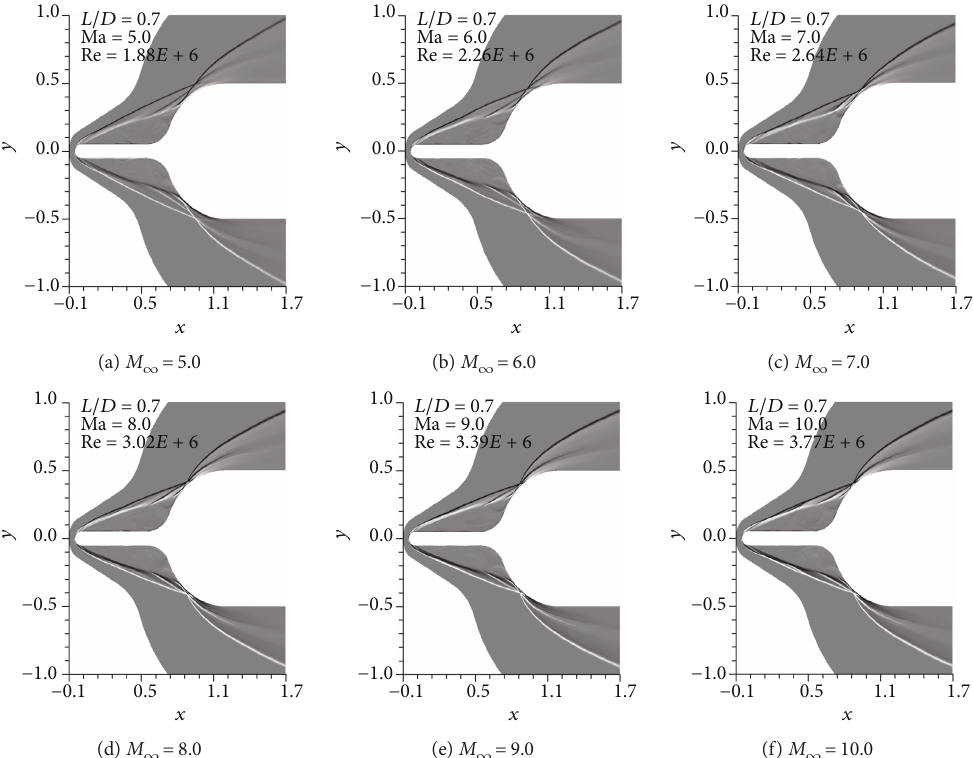
Figure 10: Flow fi eld density gradient in y direction of spiked blunt bodies with the sideward sonic jet. Spike length L/D =